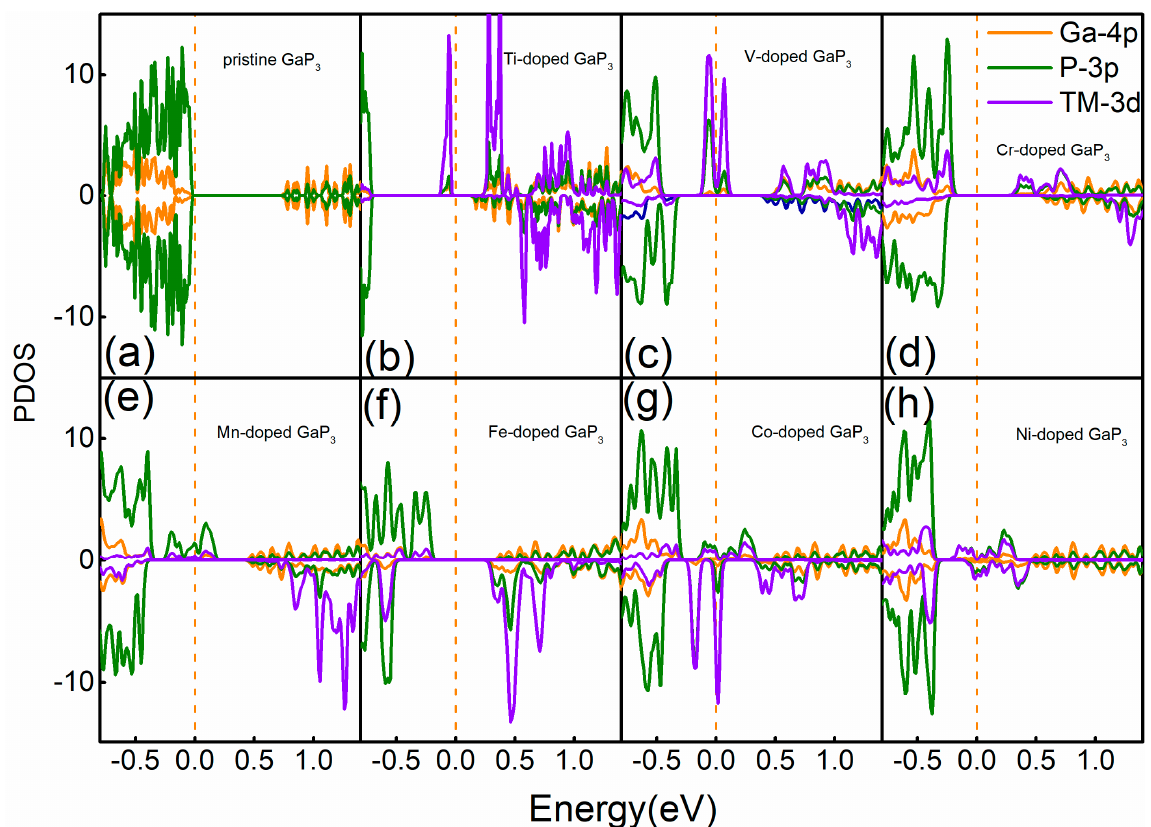
Figure 3. Projected density of states (PDOS) of the different doped systems, ( a ) pure system, ( b ) Ti–doped system, ( c ) V–doped system, ( d ) Cr–doped system, ( e ) Mn–doped system, ( f ) Fe–doped system, ( g ) Co–doped system and ( h ) Ni–doped system, respectively.